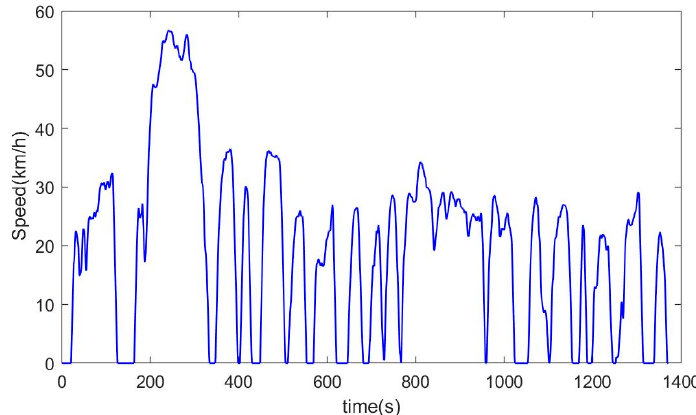
Figure 6. Urban Dynamometer Driving Schedule driving cycle.